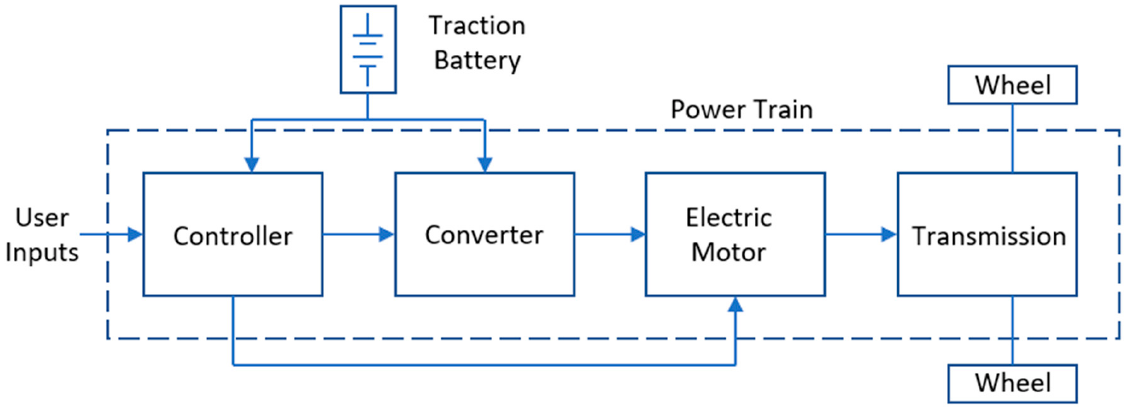
Figure 7. Block diagram highlighting the key components of an electric powertrain, redrawn from [48].